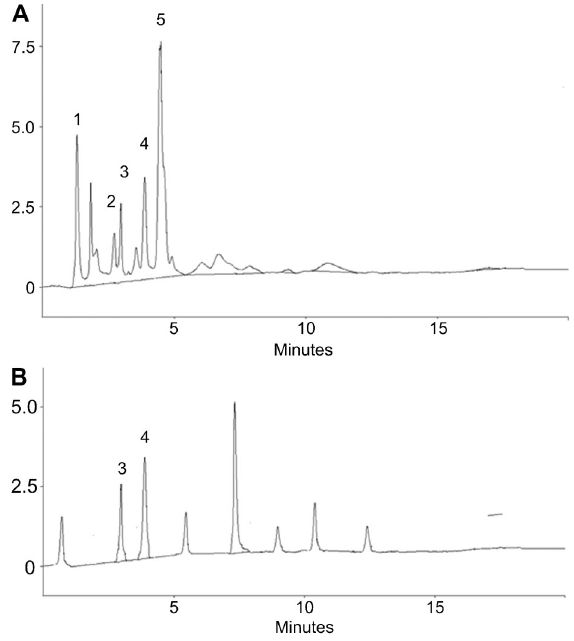
Figure 1. Chromatogram of A. crassiflora ( A ) and A. coriacea ( B ) seed extracts. 1: caffeic acid; 2: p-coumaric acid; 3: ferulic acid; 4: sinapic acid; 5: rutin.